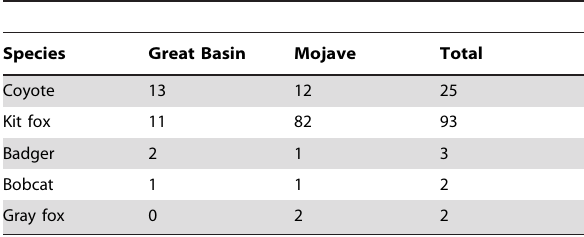
Table 2. Number of visits to scent stations by species of carnivores in 2011 and